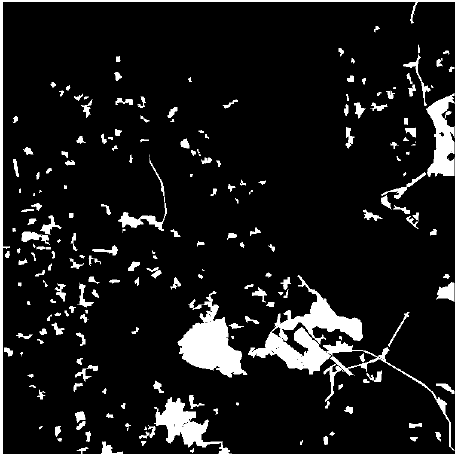
Figure 3. Ground truth data obtained by manual digitizing.